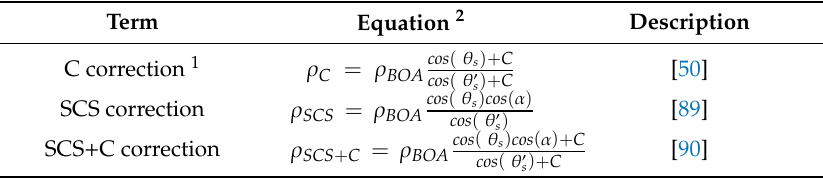
Table 2. Topographic correction methods for RT-BRDF performance